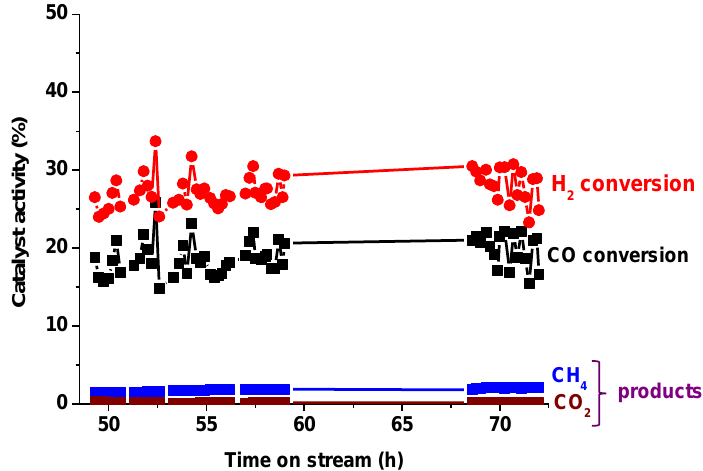
Figure 2. The activity of the Co/C catalyst extended to 72 h on stream at 500 K, 2 MPa and GHSV = 2000 cm 3 h − 1 g − 1 of the catalyst.